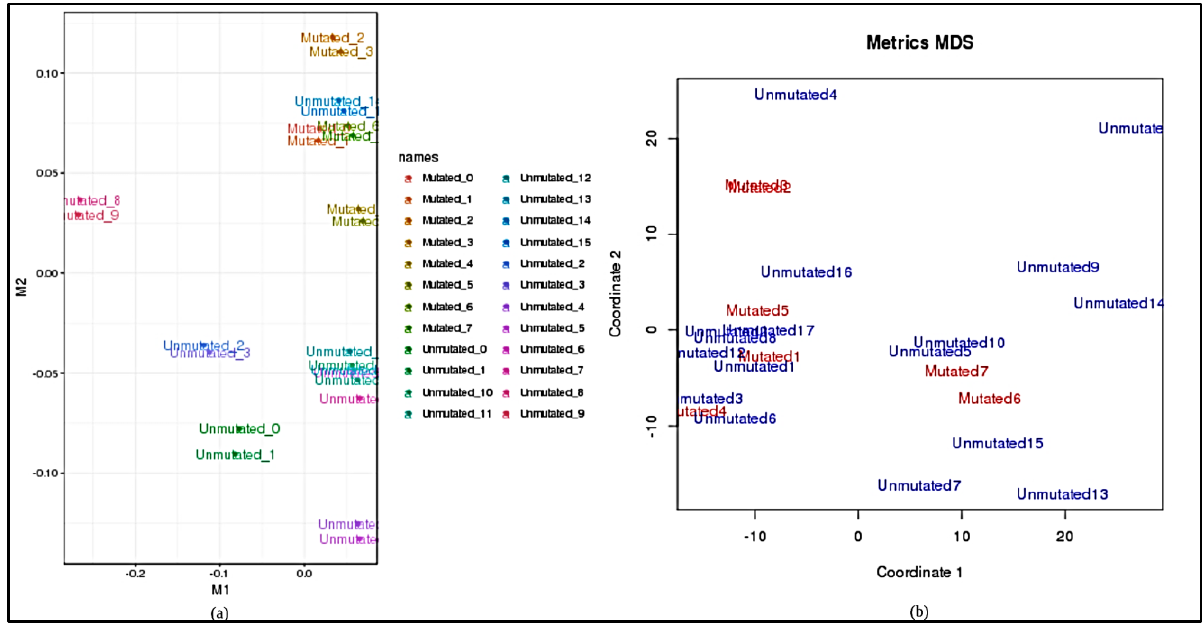
Figure 2. MDS Analysis Plots: (a) RNAseq; (b)